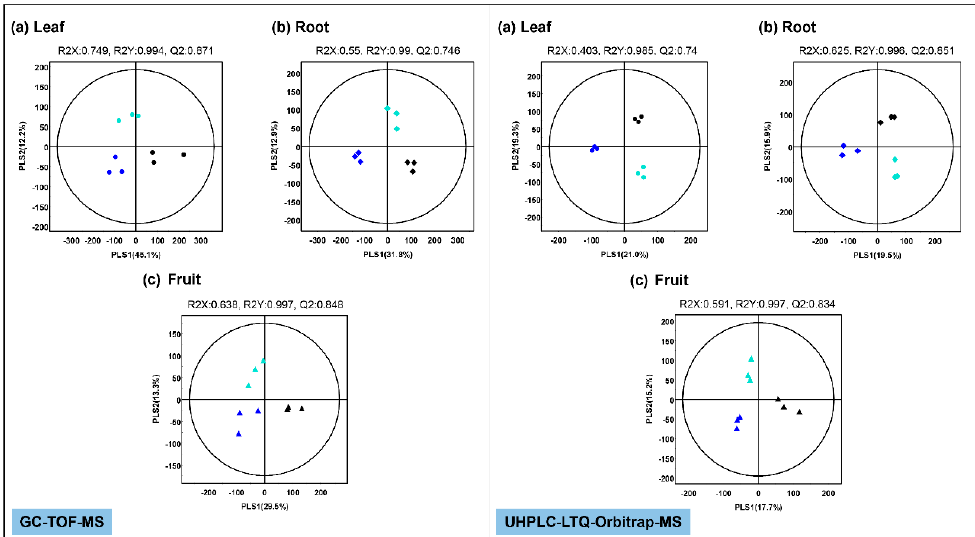
Figure 2. Partial least squares-discriminate analysis (PLS-DA) score plots for metabolites in tomato leaves, roots, and fruits under control and Mg oversupply conditions based on the GC-TOF-MS and UHPLC-Orbitrap-MS data set. ( a ) score plot for control ( (cid:8) ), MgH ( (cid:8) ), and MgEH ( (cid:8) ) leaf samples, ( b ) score plot for control ( (cid:7) ), MgH ( (cid:7) ) and MgEH ( (cid:7) ) root samples, ( c ) score plot for control ( (cid:78) ), MgH ( (cid:78) ), and MgEH ( (cid:78) ) fruit